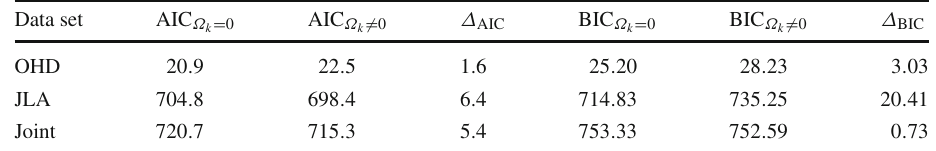
Table 2 Values for AIC and BIC for each data set for the flat and non-flat cases. The Δ refers the difference of these values with respect the minimum value